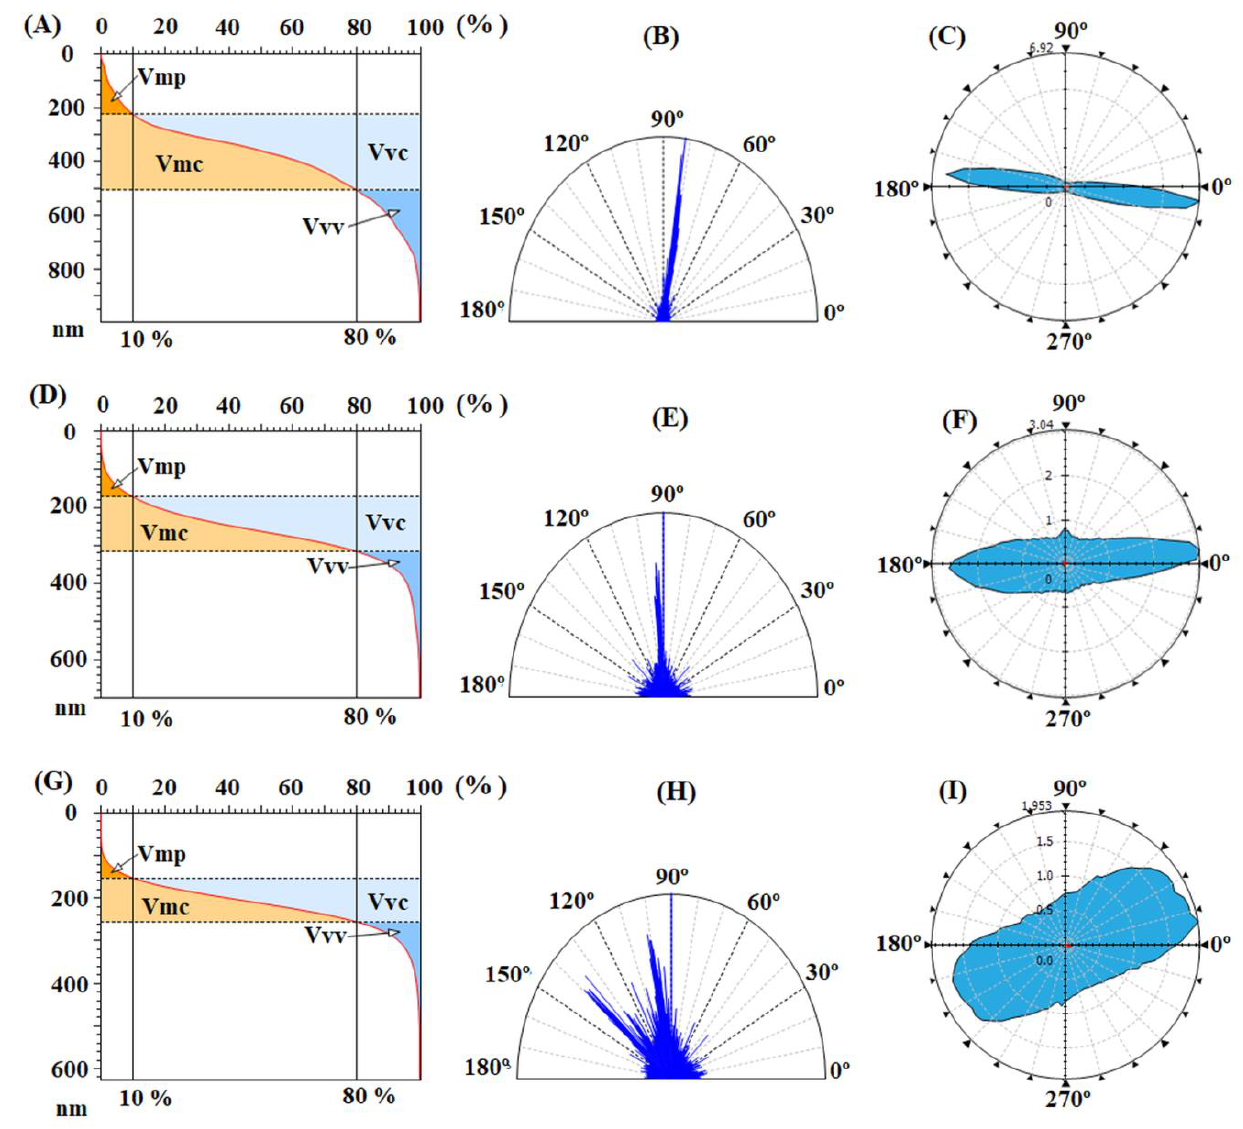
Figure 9. Abbott – Firestone curves with functional volume parameters, texture direction represen- tations and graphs with polar coordinates to analyze orientation with azimuth angle obtained for rubbed CBDA-pBAPS (1R) ( A – C ), CBDA-pBAPS (2R) ( D – F ) and CBDA-pBAPS (3R) ( G – I ) samples.